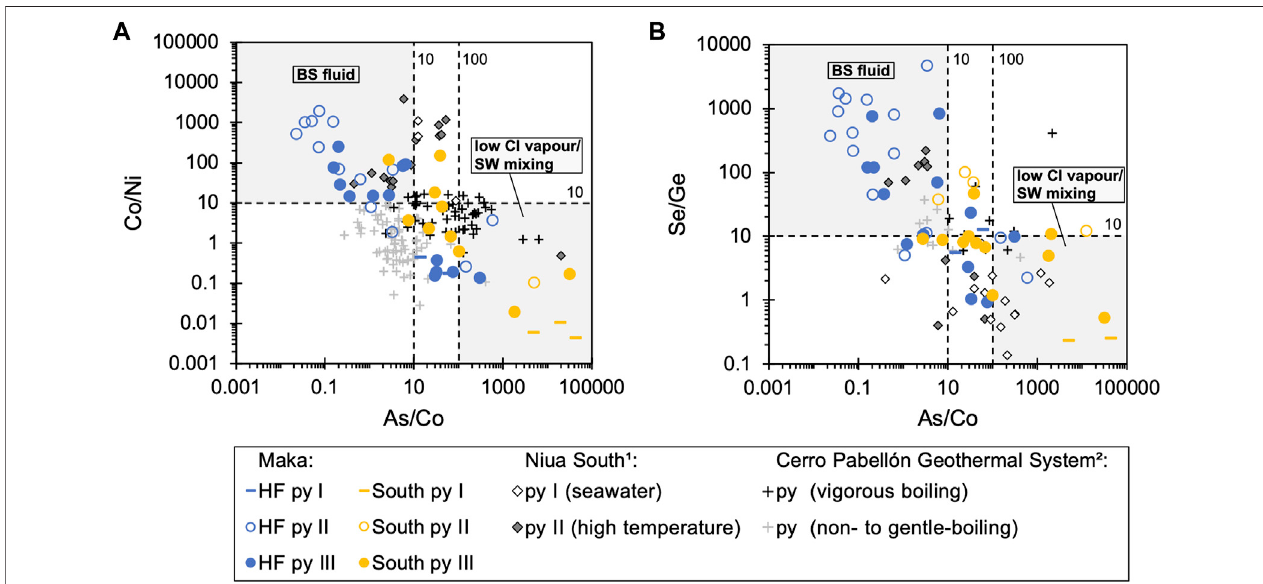
FIGURE 5 | Diagram showing trace elements ratios of (A) Co/Ni and (B) Se/Ge versus As/Co. Note that pyrite, which formed from black smoker-type fl uids with seawater-likechlorinitiesischaracterisedbyhighCo/Ni( > 10)and Se/Ge( > 10)and lowAs/Co( > 10 – 100), whereaspyritethatformed fromlow-Cl vapour-rich fl uidsand/ or by seawater mixing shows low Co/Ni ( < 10) and Se/Ge ( < 10) and high As/Co ( > 10 – 100). For a more details, please see Section 5.3 . Superscripts: 1 (cid:1) (Falkenberg et al., 2021), 2 (cid:1) (Román et al., 2019)